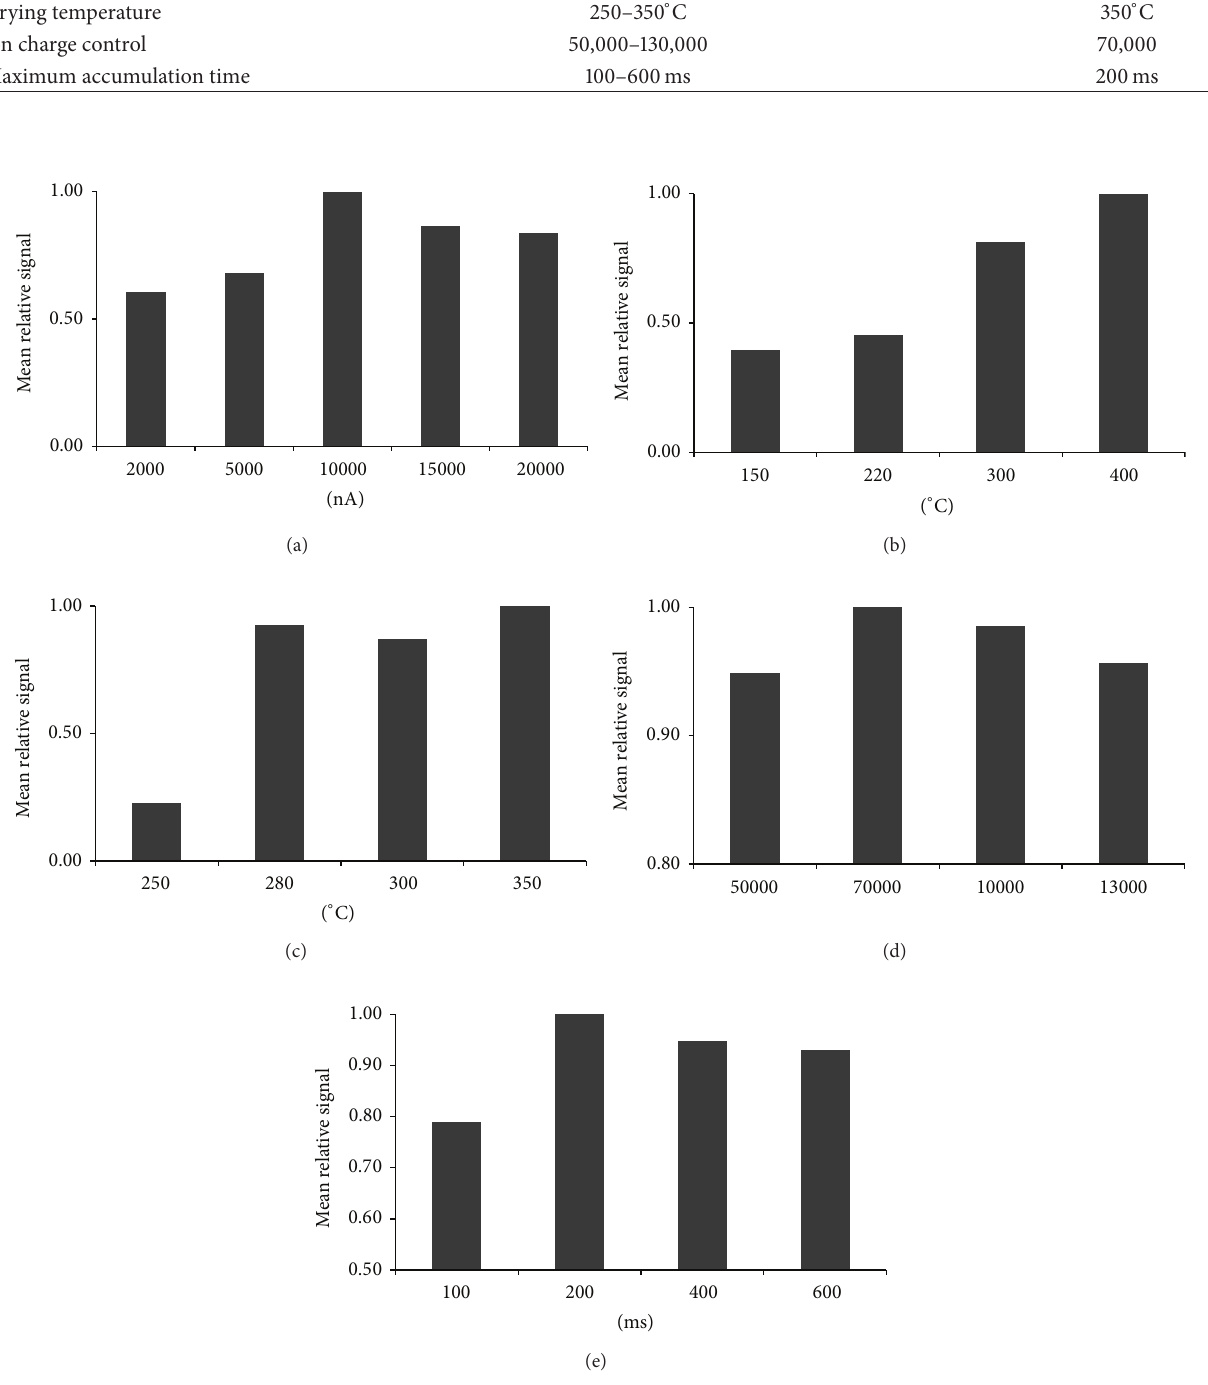
Figure 1: Evaluation of selected parameters for optimization of MS conditions by the average signal of CC derivatives: (a) corona needle (nA); (b) vaporization temperature ( ∘ C); (c) drying temperature ( ∘ C); (d) ion charge control; and (e) maximum accumulation time